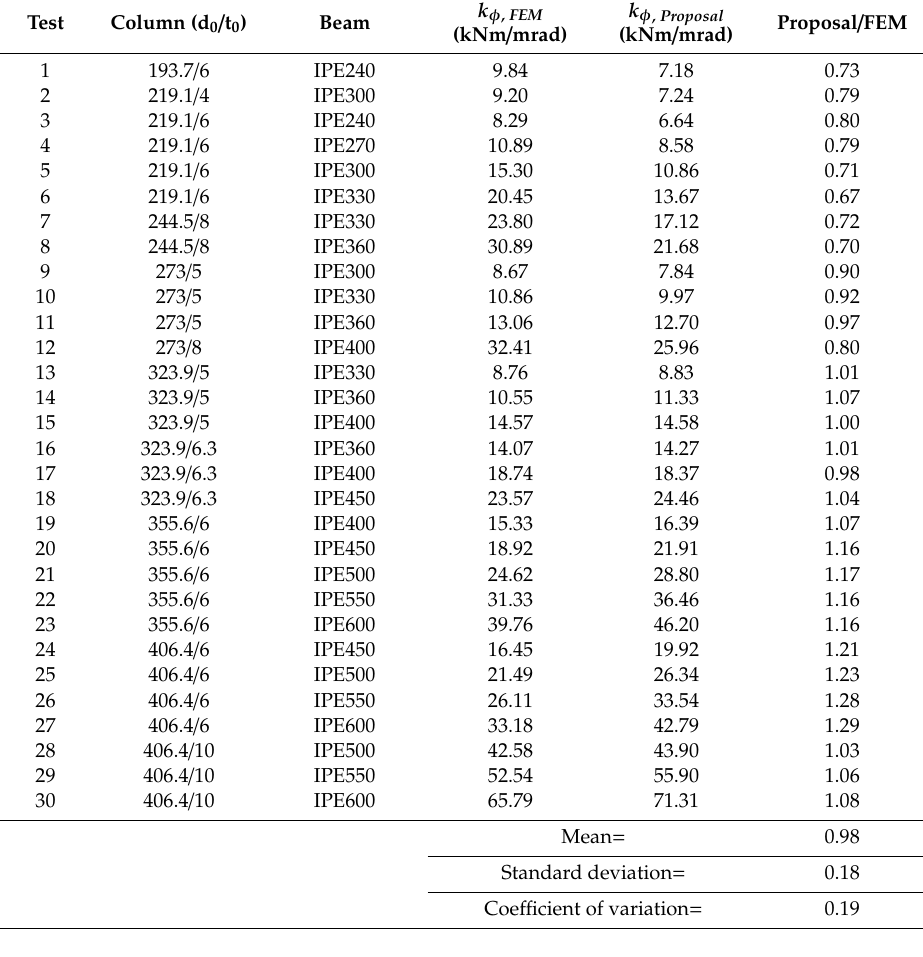
Table 3. Comparison between the sti ff ness provided by the numerical outcomes and by the proposed formulation.